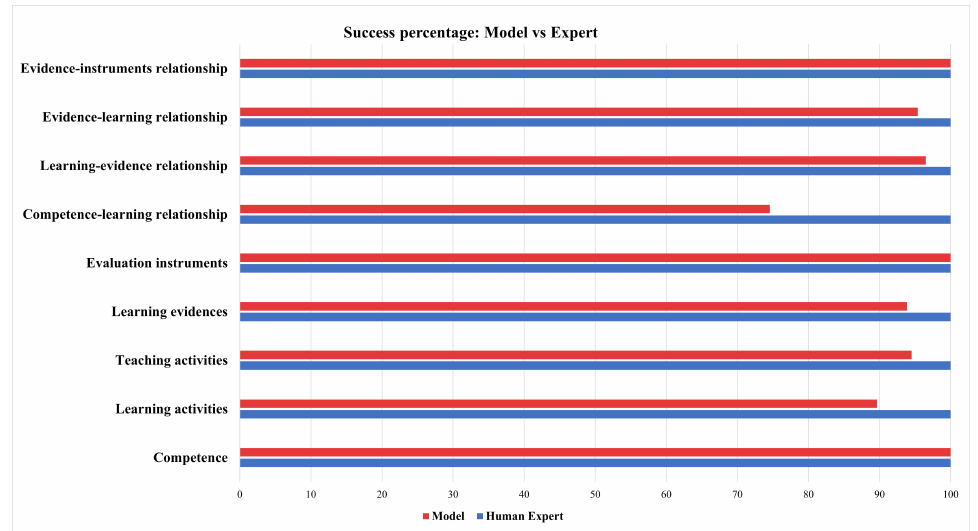
Figure 10. Success percentage: Framework vs. Human expert.